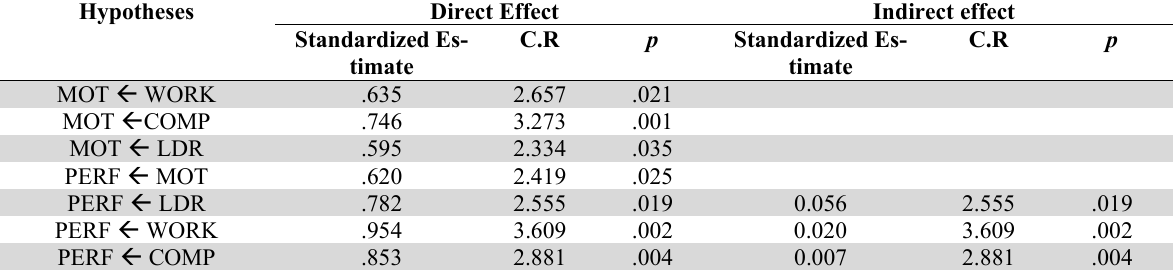
Recapitulation of direct effect and indirect effect parameter